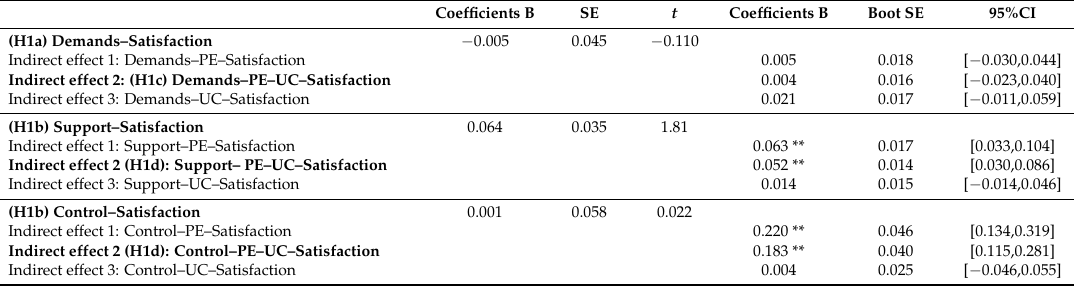
Table 2. Results of mediation test of psychological empowerment and union commitment between job demands-resources and job